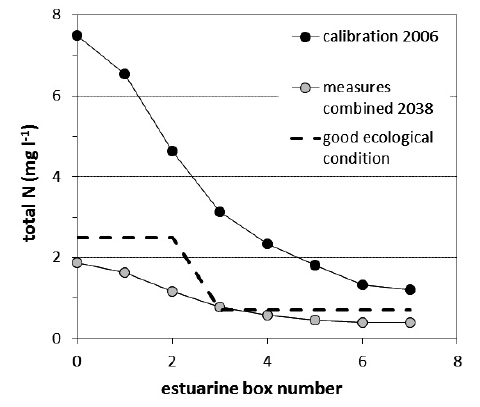
Fig. 5. Output of the ExtendSim estuarine box-model for the estuarine part of the Scheldt for business-as-usual in 2006 and for measures (2) to (5) combined in 2038 (Fig. 4). EU Water Framework Directive standards of good ecological status are 2.5 mg N/L of total N for the river stretch and 0.46 mg N/L of winter dissolved inorganic N (taken from the river basin management plan, RBO Schelde 2008). The latter corresponds to 0.7 mg N/L of total N in 2006, which we used here for graphical reasons. Annual mean total nitrogen in the inflowing North Sea water from the south into the coastal zone off the Scheldt is on the order of 1.2 mg